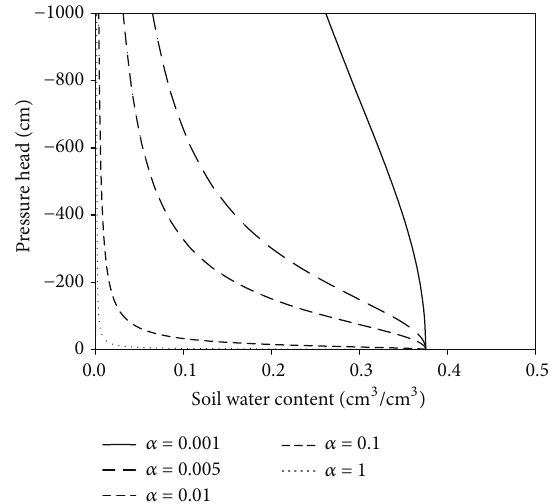
Figure 4: Relations between pressure head and soil water content for five different values of the 𝛼 parameter used in the simulation model.